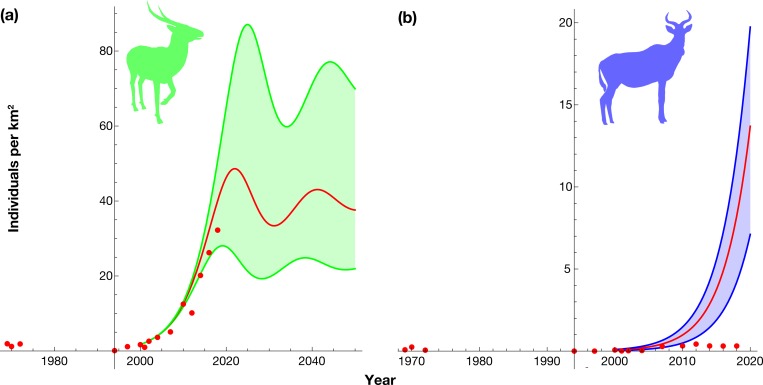
Observed pre- and post-war aerial survey data (red points) plotted against logistic-growth curves for (a) waterbuck and, (b) hartebeest. Vertical axes (number of individuals per km2 surveyed) intersects horizontal axes (year) in 1994, coinciding with the first post-war survey. For waterbuck, logistic curves are plotted using an intermediate K estimate (red line) along with plausible upper- and lower-bound K estimates (green lines and shaded interval). For hartebeest, logistic curves are plotted using the observed initial post-war density estimate (red line) ± 50% (blue lines and shaded interval), assuming the intermediate K value.